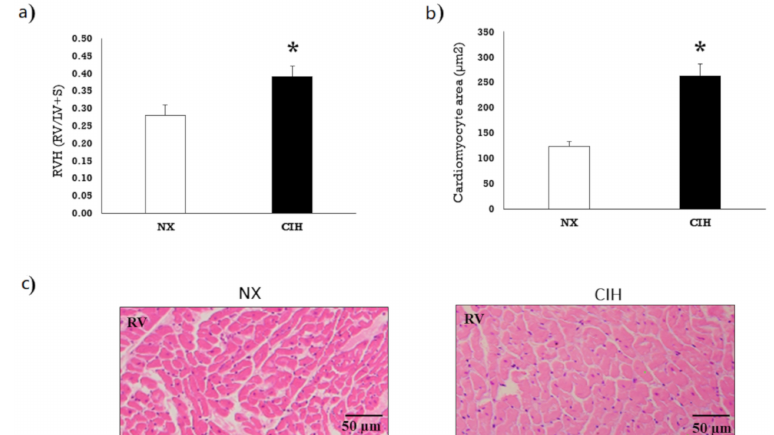
Figure 1. ( a ) Degree of right ventricle hypertrophy (RVH) by Fulton’s index (right ventricle (RV) / left ventricle plus septum (LV + S)) after exposure to normoxia (NX; n = 10) and chronic intermittent hypobaric hypoxia (CIH; n = 10); ( b ) Cardiomyocyte area in the RV ( µ m 2 ); ( c ) Representative image of hematoxylin-eosin-stained RV tissue. The values are the mean (x) ± standard error (SE). * p < 0.05: CIH group vs. NX group.